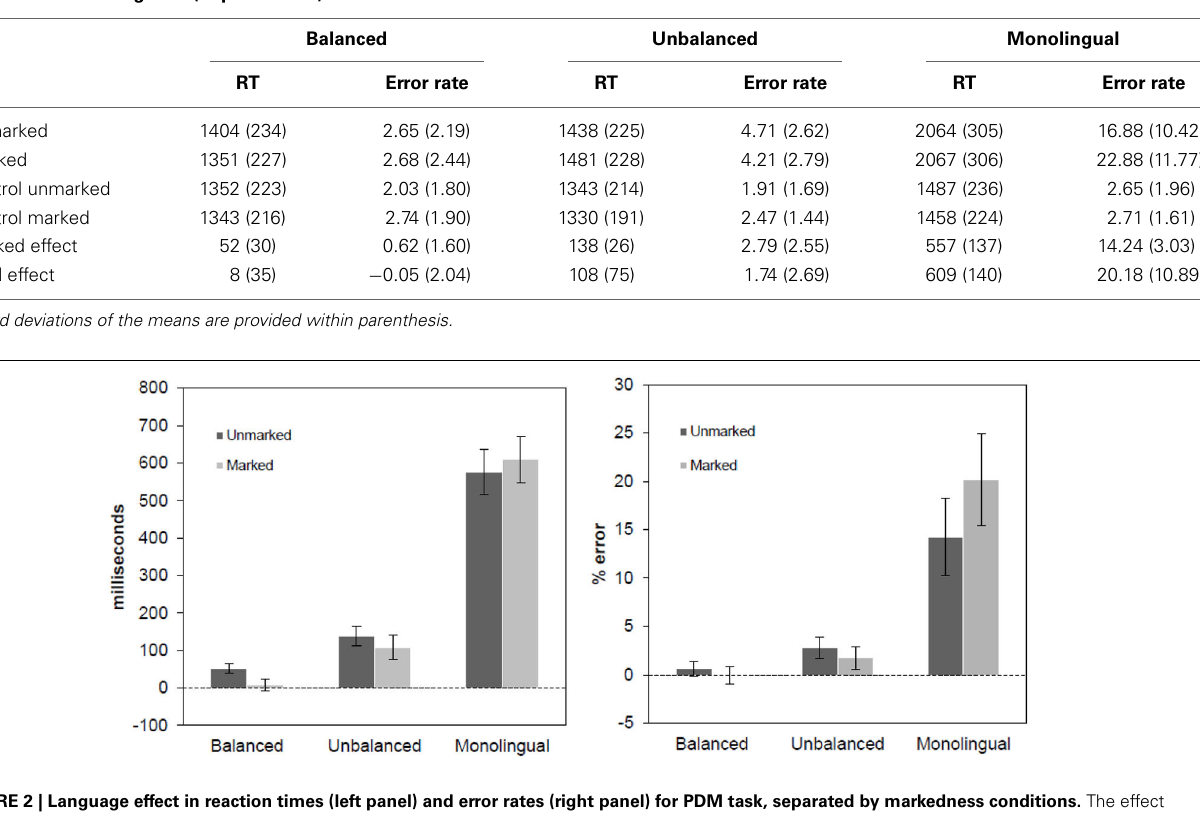
Table 4 | Mean latencies (in milliseconds) and error rates (in percentage) for words in the four conditions and participant groups for progressive demasking task (Experiment